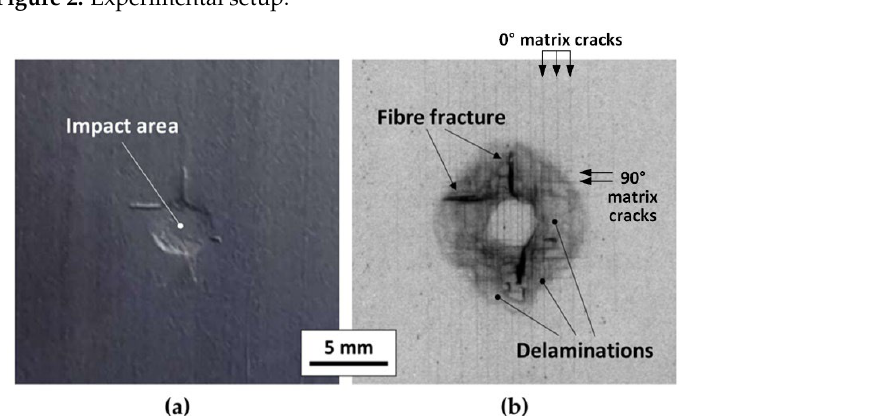
Figure 2. Experimental setup.